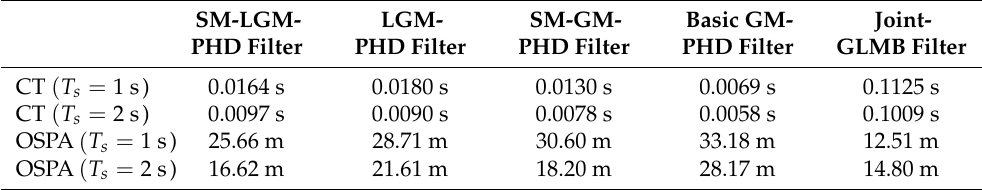
Table 2. List of the average CT and average OSPA of each filter in example 1 (CV model).